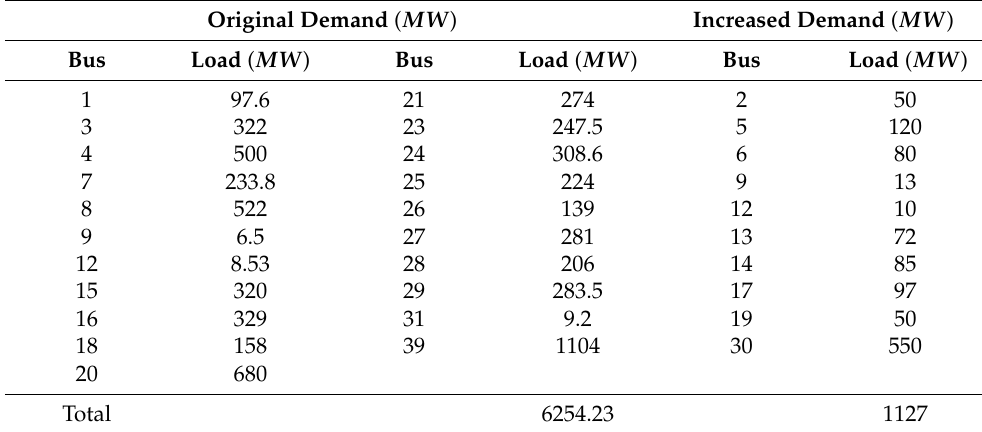
Table 11. The 39-bus system increment in energy demand versus the base year demand.